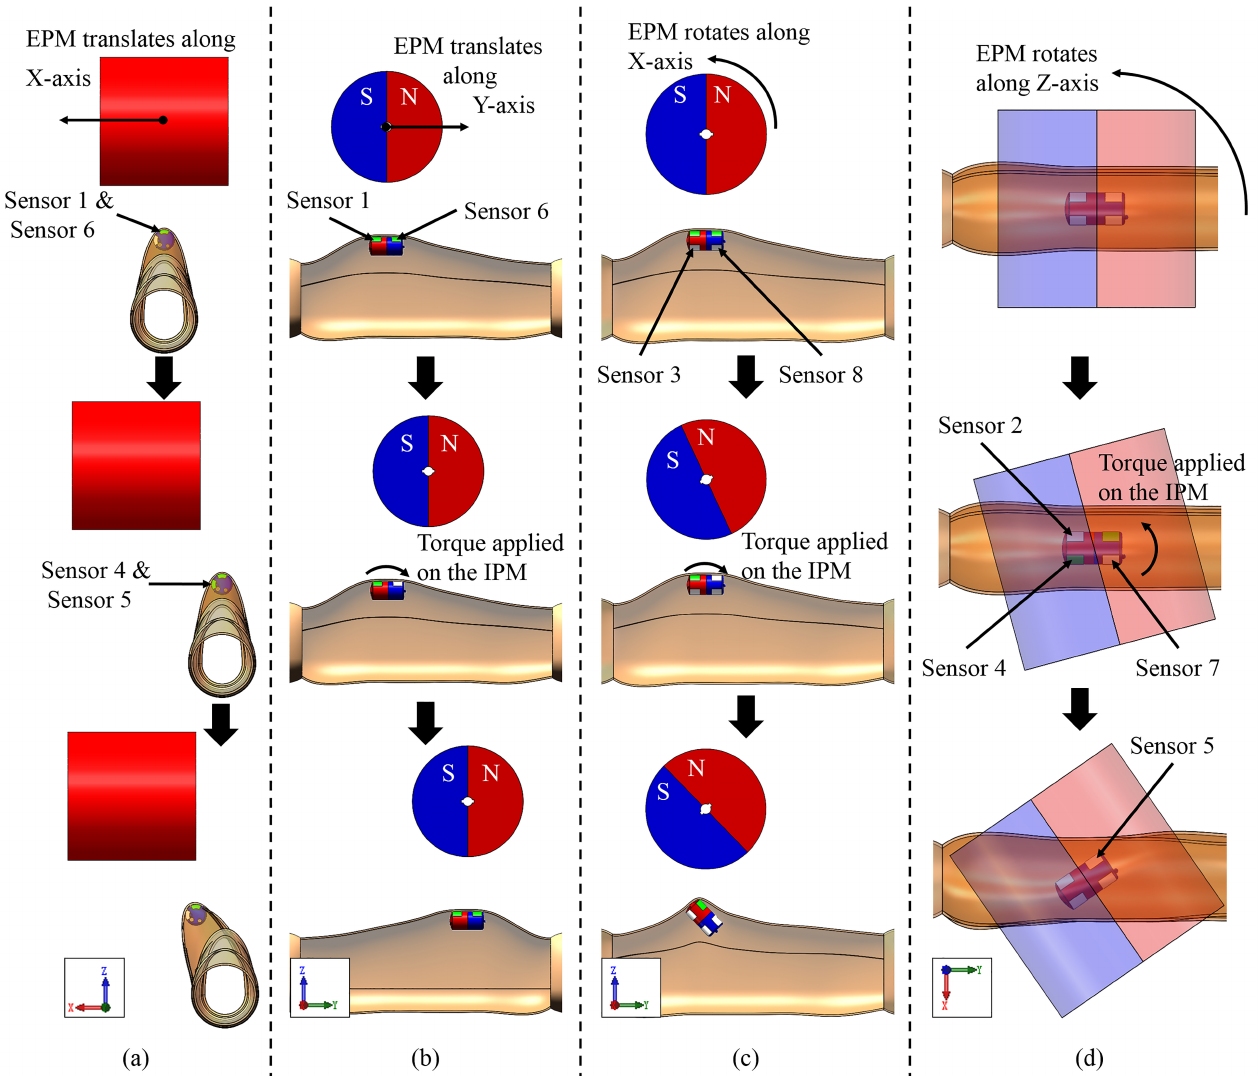
Figure 7. Corresponding motion directions of the magnetic capsule when the EPM moves in various directions. ( a ) The EPM translates along its X-axis. ( b ) The EPM translates along its Y-axis. ( c ) The EPM rotates along its X-axis. ( d ): The EPM rotates along its